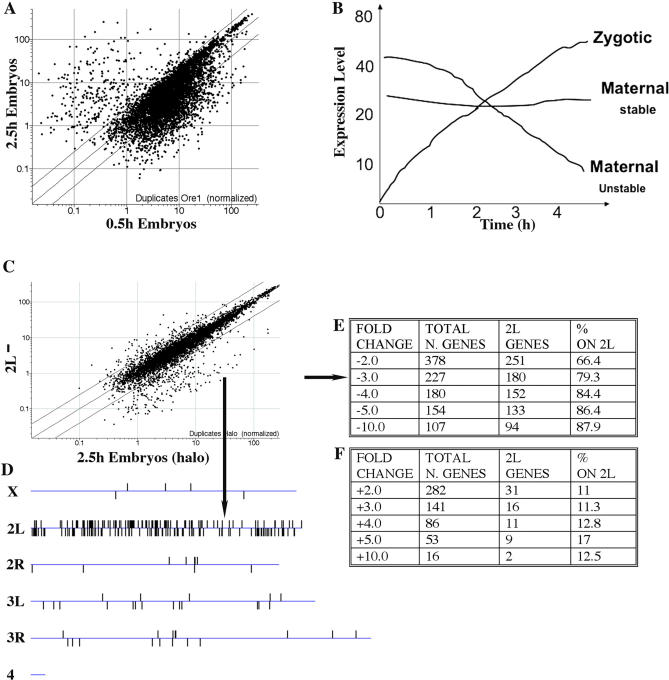
Time-Course Analysis of the MZT and Ablation of the Left Arm of the Second Chromosome(A) Scatter plot representation of freshly fertilized eggs (0–1 h = 0.5 h) and mid-cycle 14 embryos (2–3 h = 2.5 h) microarray measurements. This result represents the average of two biological replicates. Note the extensive degradation of maternal mRNAs appearing as a large number of dots below the 3-fold diagonal lines. Each dot corresponds to an individual probe. The labeling “Duplicates OreR” in the x-axis of the scatter plot refer to the fly strain (Oregon R) used to collect the WT embryos.(B) Cartoon indicating the three possible outcomes of time-course microarray measurements during the MZT.(C) Scatter plot analysis of embryos missing the left arm of the second chromosomes (2L−) compared to similarly staged cycle 14 embryos mutant for the halo gene. Both population of embryos were identified based on the halo phenotype, see also Figure 2E. Results represent the average of four biological replicates.(D) Genes whose expression was down-regulated 3-fold in the 2L− collection map predominately to 2L.(E and F) Chromosomal distribution of down-regulated (E) and up-regulated (F) genes at different cut-off (p < 0.001). Only down-regulated genes were enriched on 2L.